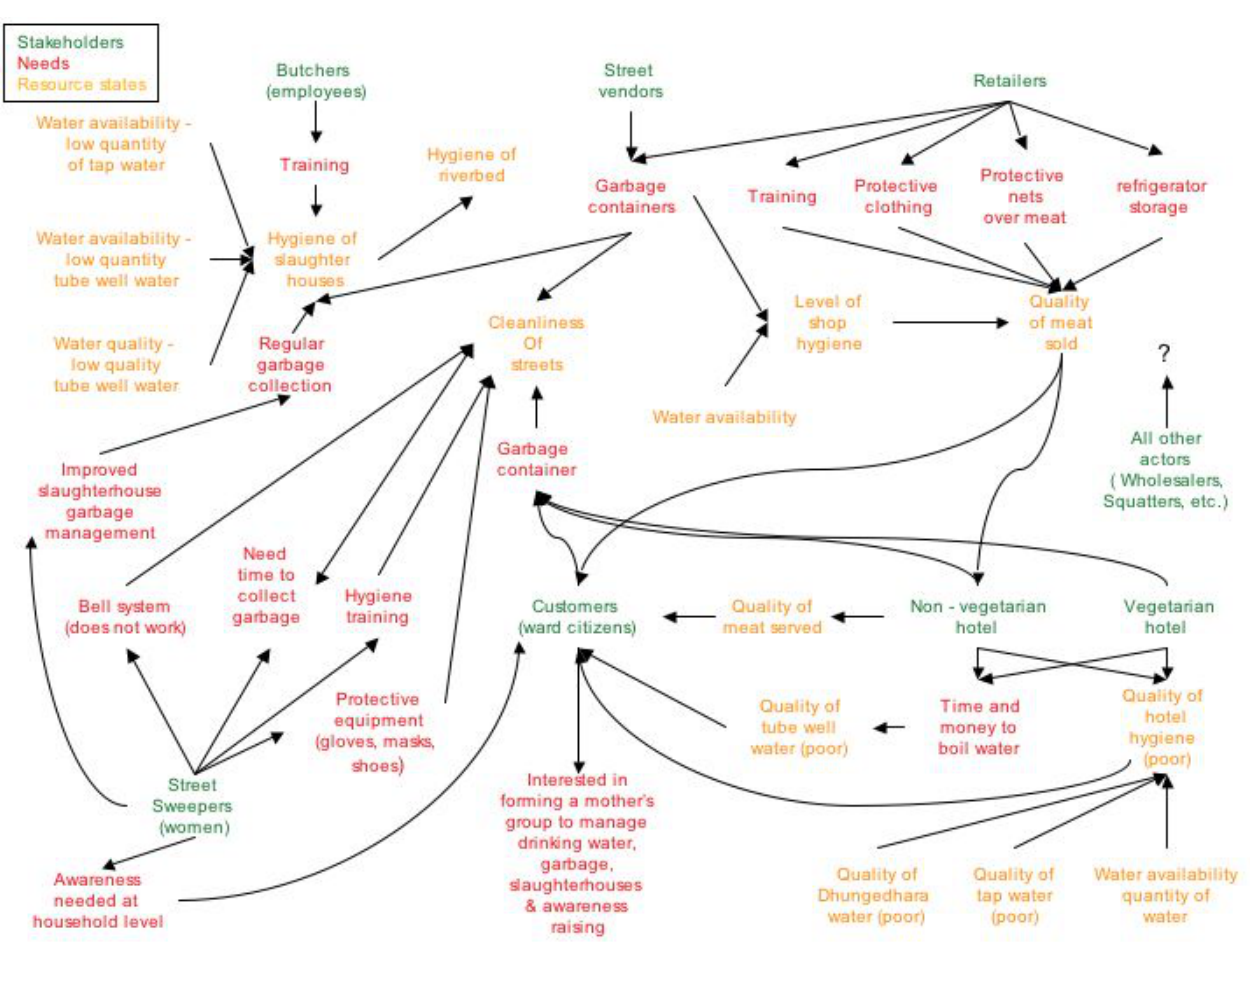
Fig. 9 . Stakeholder needs and resource states - water, food and